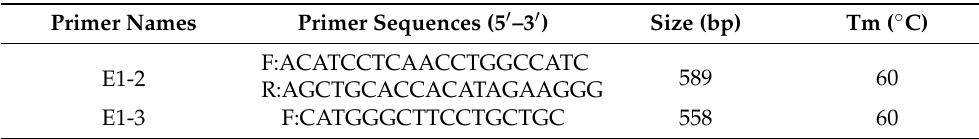
Table 1. Primer information of SSTR1 of Hulun Buir